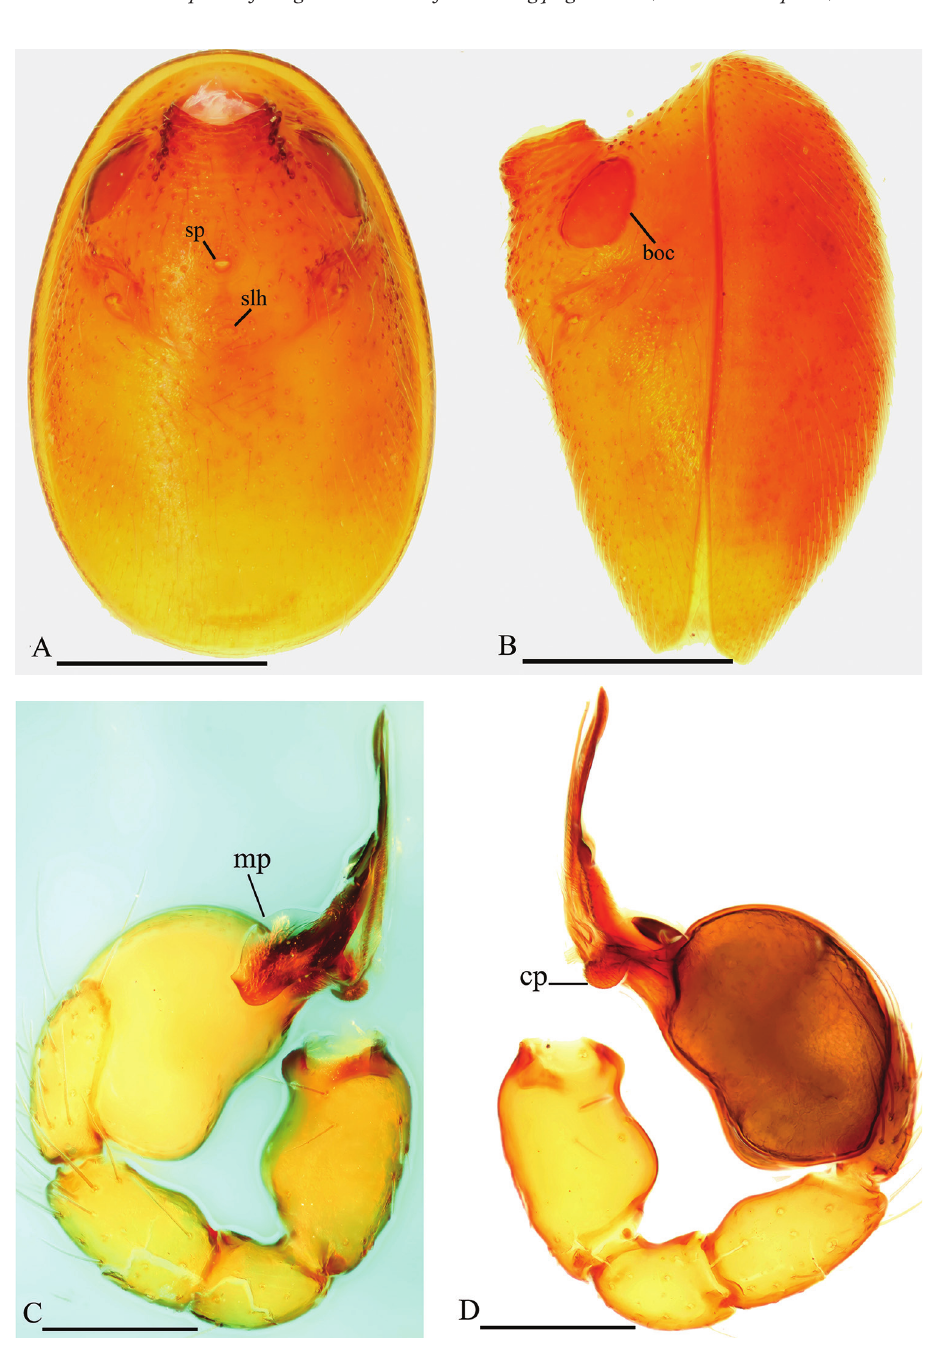
Figure 2. Trilacuna simianshan sp. n., male. A abdomen, ventral view B abdomen, lateral view C left palp, prolateral view D left palp, retrolateral view. Abbreviations: boc = booklung covers; cp = circular projection; mp = membranous projection; slh = small hole; sp = sperm pore. Scale bars: 0.2